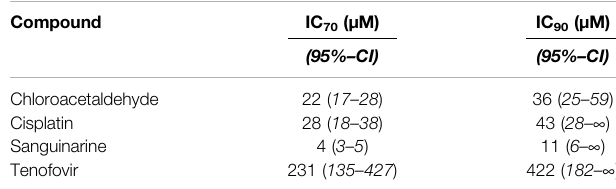
TABLE 1| Overview of prototypic nephrotoxicants with calculated IC 70 - and IC 90 - concentrations. IC 70 - and IC 90 -concentrations are de fi ned as inhibitory concentrations that result in 70% and 90% of the maximal inhibitory effect on cellular metabolic activity, respectively. IC 70 and IC 90 concentrations were based on and calculated using IC 50 -values of mean cellular metabolic activity concentration-response curve fi ttings ( Figure 1 ). 95% con fi dence bands were plotted in curve fi tting graphs and used to calculate con fi dence intervals (CI) for IC 70 and IC 90